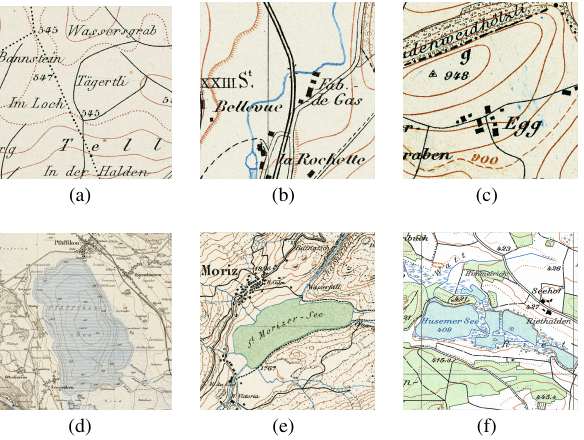
Figure 6. Comparison between indicated uncertainty levels. The uncertainty is normalized by the content of segmented features. The box plot shows the minimum, the maximum, quartiles and the median.